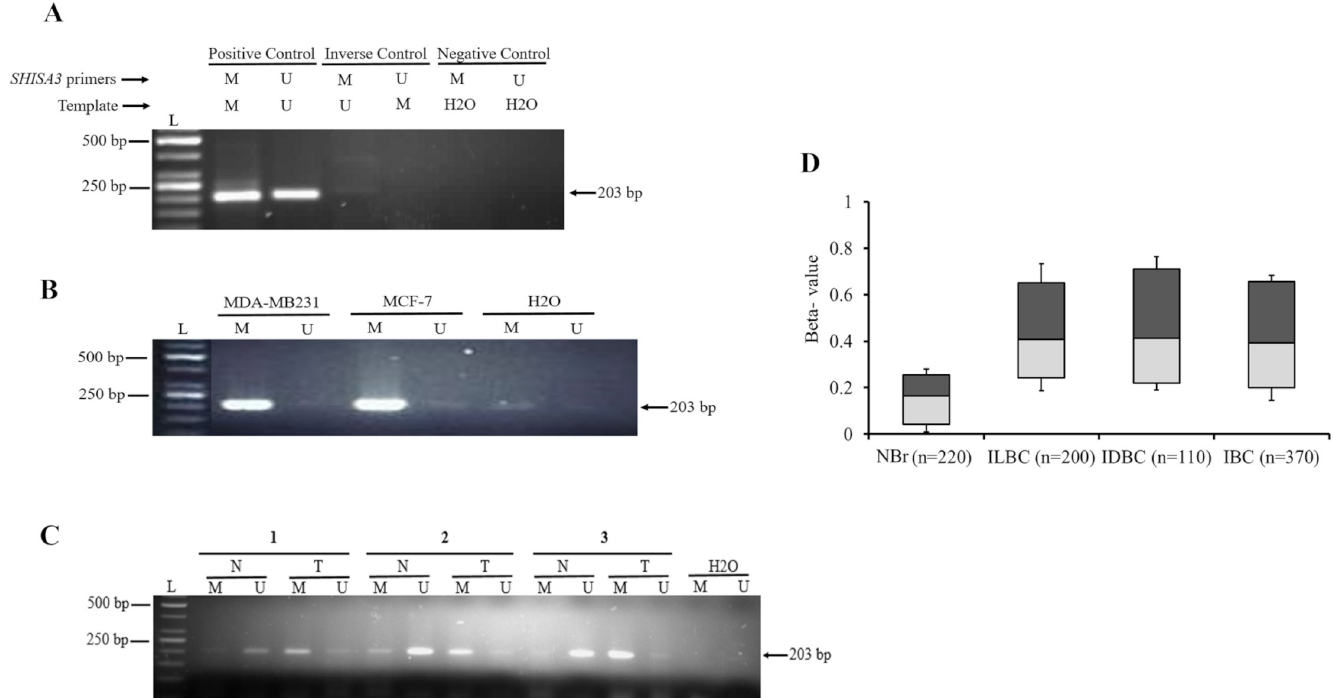
Fig 2. Methylation analysis of SHISA3 promoter in breast cancer. A) Methylation analysis of SHISA3 in breast cancer cell lines. B) Representative image of MSP of SHISA3 gene in paired BC tissue samples. In all agarose gels images, L: DNA Ladder (50bp), N: normal tissue, T: tumor tissue, M: methylated, U: un-methylated, water was used as negative control for both methylated and un-methylated primers. C) In silico analysis of SHISA3 methylation levels in normal and various breast cancer